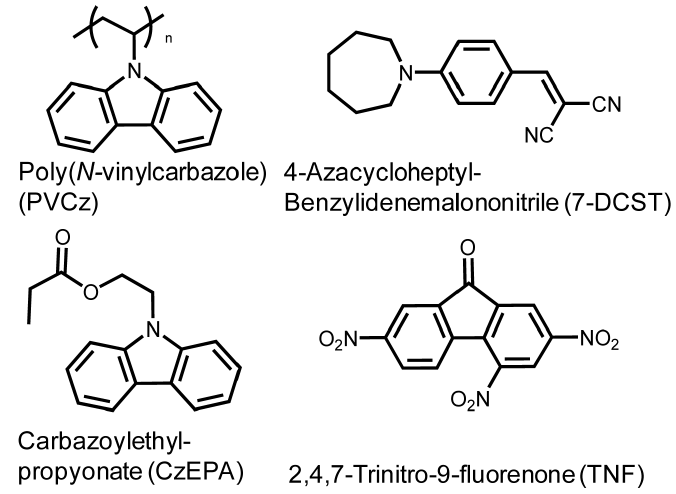
1. Structural formulae of poly( N -vinyl carbazole) (PVCz), 4- azacycloheptylbenzylidene-malonitrile (7-DCST), carbazolylethylpropionate (CzEPA), and 2,4,7-trinitro-9-fluorenone